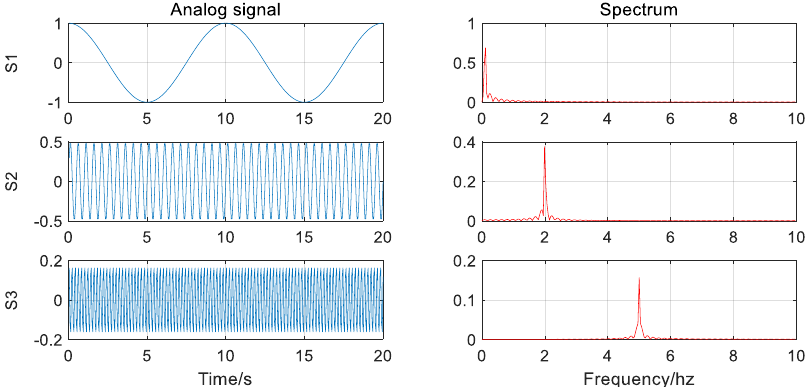
Figure 3. Signal waveform and corresponding spectrogram (without noise).